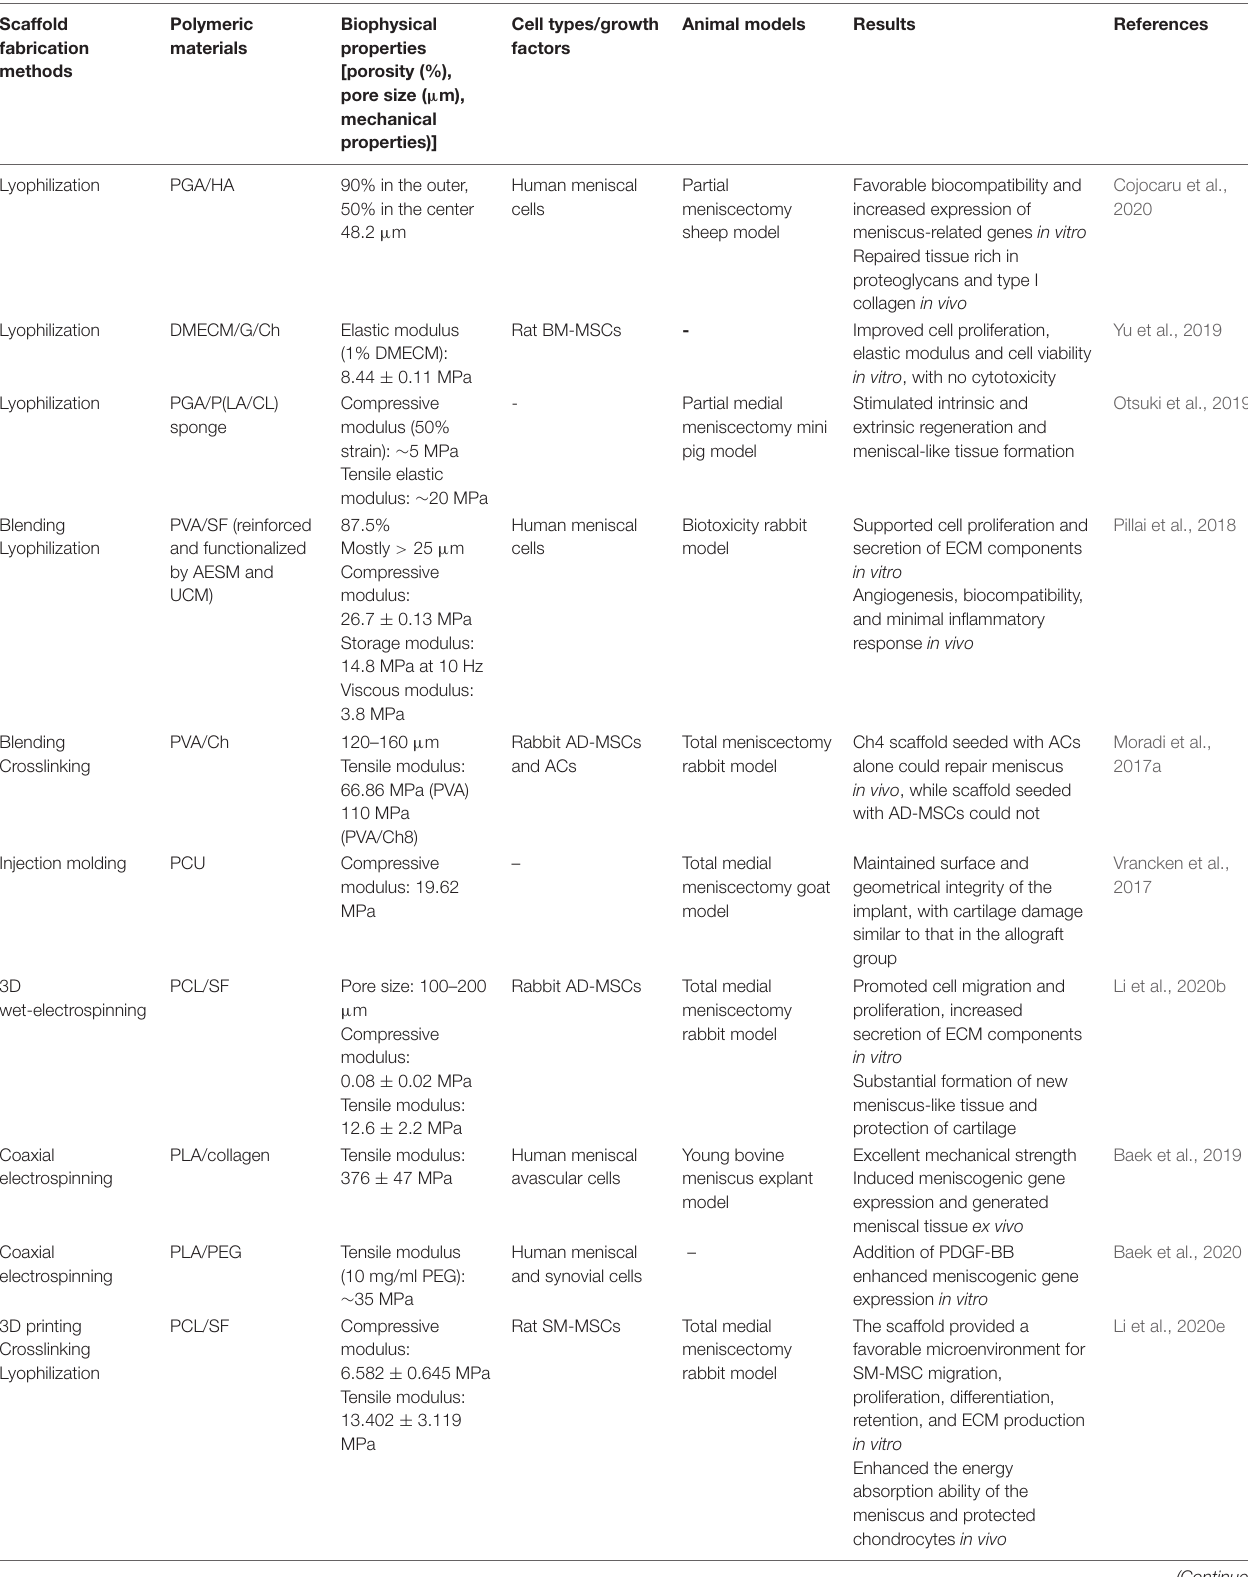
TABLE 4 | Summary of the most relevant examples of meniscal scaffold fabrication